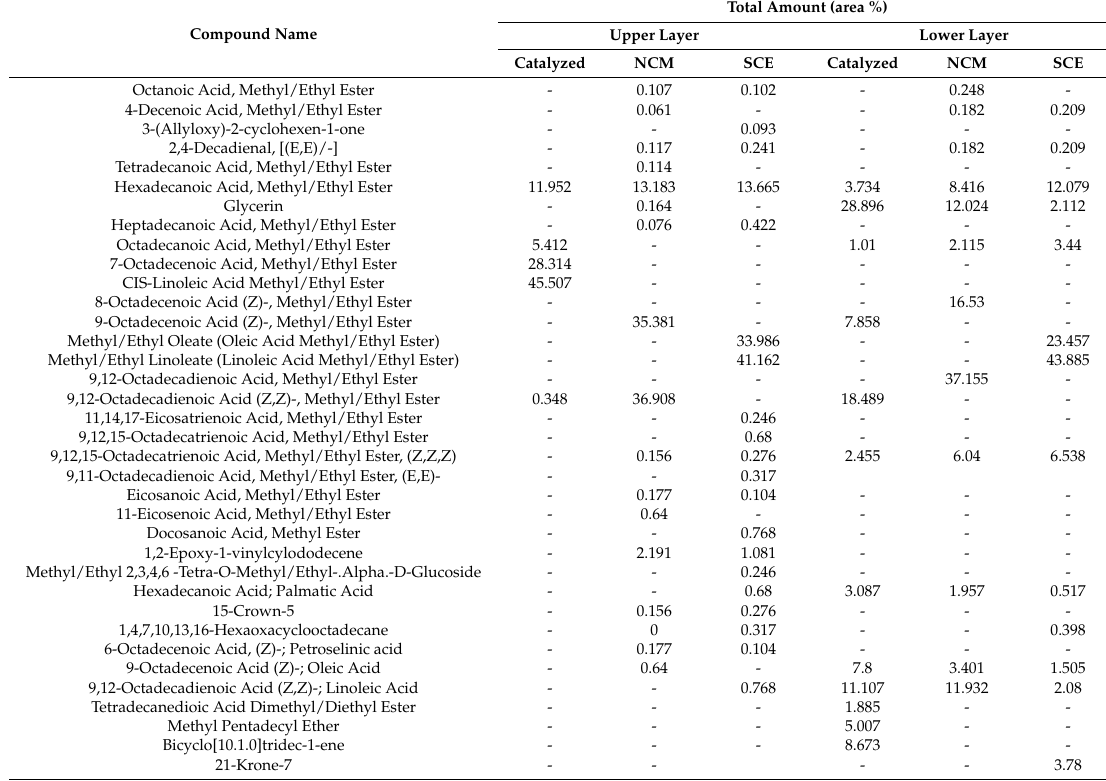
Table 5. Components obtained from the catalyzed and supercritical processes of VCO in terms of area % as obtained from GC